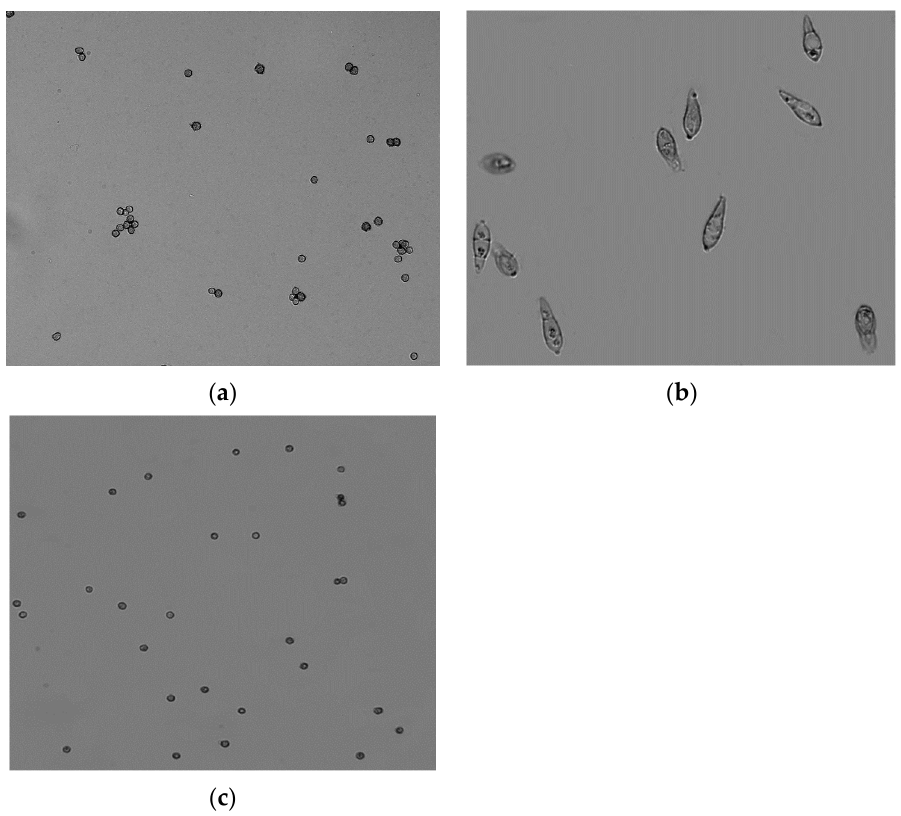
Figure 8. The images of spores in the enrichment area of the microfluidic chip, ( a ) is image of Ustilaginoidea virens spores, ( b ) is image of Magnaporthe grisea spores, ( c ) is image of Aspergillus brasiliensis spores.